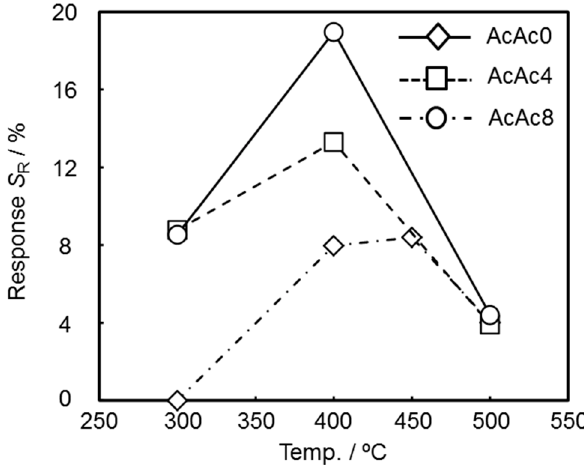
Figure 9. Response transients in resistance R and capacitance C components of the SmFeO 3 thin-film devices prepared from AcAc0, 4 and 8 precursors to 5–15 ppm C 2 H 2 at ( a ) 400 and ( b ) 500°C at 20 kHz.